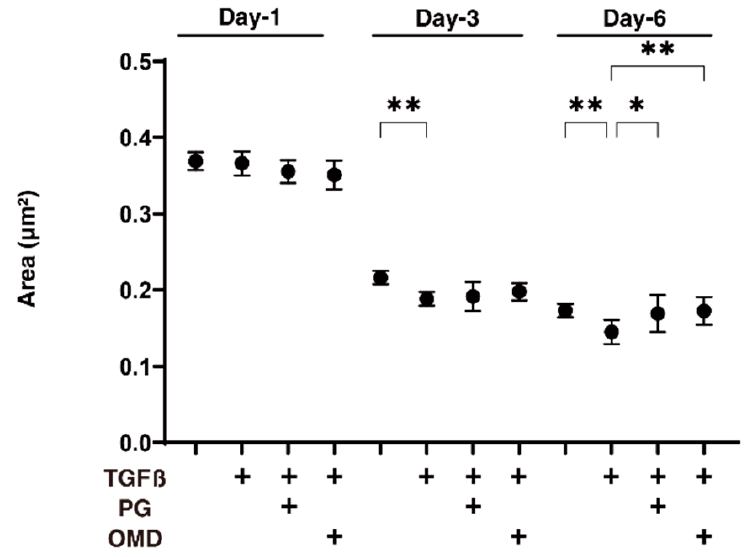
Figure 2. Effects of PGF2 α and the EP2 agonist, omidenepag (OMD), on sizes of TGF β 2-treated 3D HTM spheroids at days 1, 3, or 6.To compare the effects of 100 nM PGF2 α (PG) and omidenepag (OMD) on the mean sizes of the 5 ng/mL TGF- β 2 (TGF β ) HTM 3D spheroids, measurements were made on days 1, 3, or 6 in addition to TGF β untreated controls, and plotted ( n = 10–12 3D spheroids for each experimental condition). “+” is reagents addition. Data that are presented are the arithmetic mean ± standard error of the mean (SEM), and statistical differences were determined by ANOVA followed by a Tukey’s multiple comparison test. * p < 0.05, ** p < 0.01.